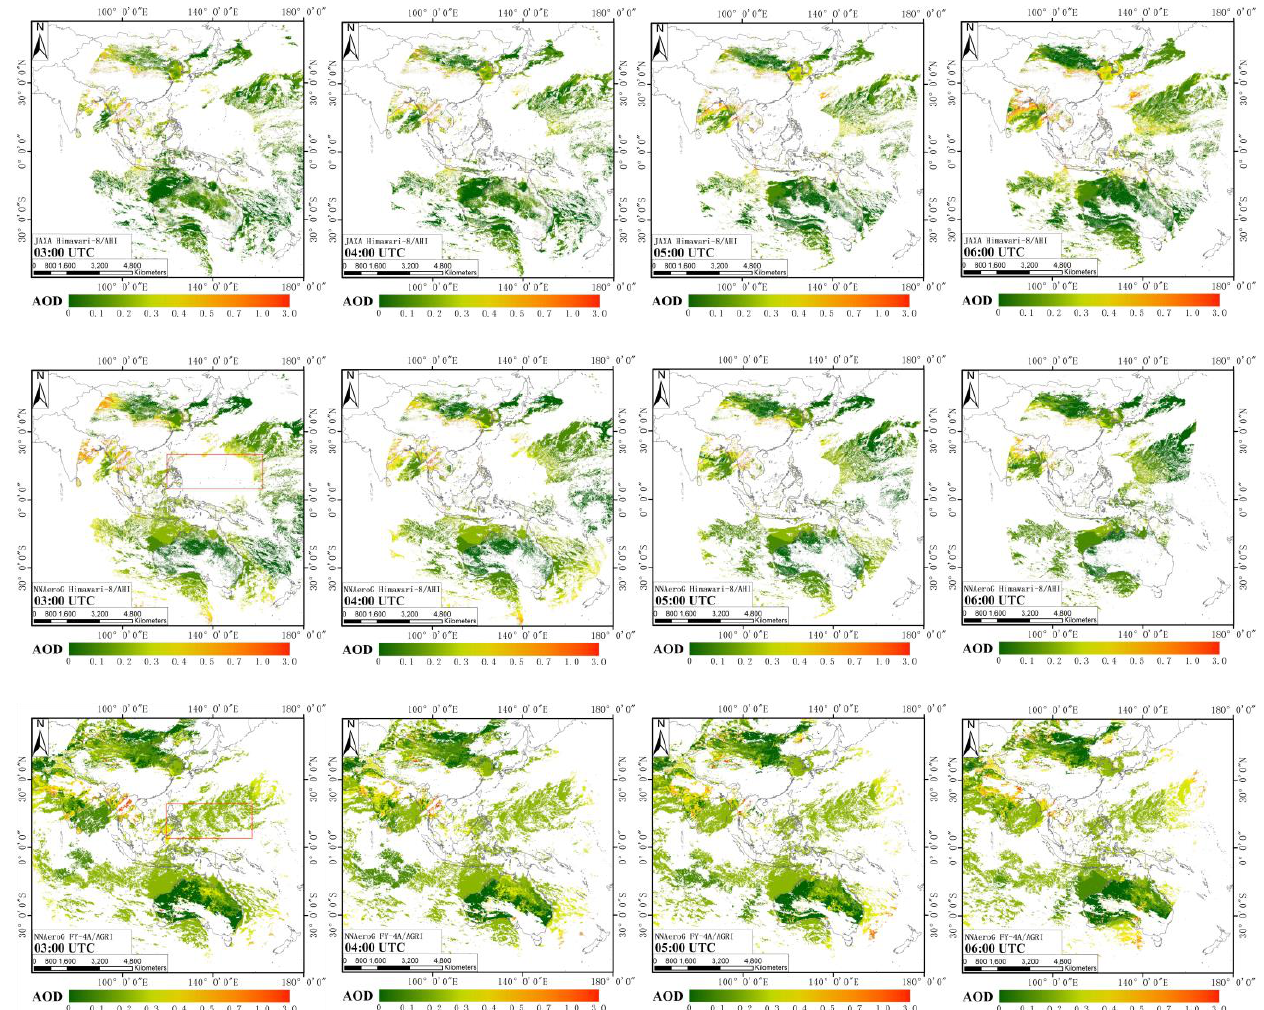
Figure 10. Hourly averaged spatial distributions of the AOD retrieved from Himawari-8/AHI and FY-4A/AGRI data over the full disk from 03:00 to 06:00 UTC on 23 April 2020. The first line is the Himawari-8/AHI AOD retrieval result obtained from the official JAXA product (Version 3.0), the second line is the Himawari-8/AHI AOD retrieval result that used the NNAeroG algorithm, and the third line is the FY-4A/AGRI AOD retrieval result that used the NNAeroG algorithm. As shown in Figure 10, the spatial distribution of FY-4A/AGRI AOD is generally con- sistent with AHI AOD. In the second column, the spatial continuity of Himawari-8/AHI